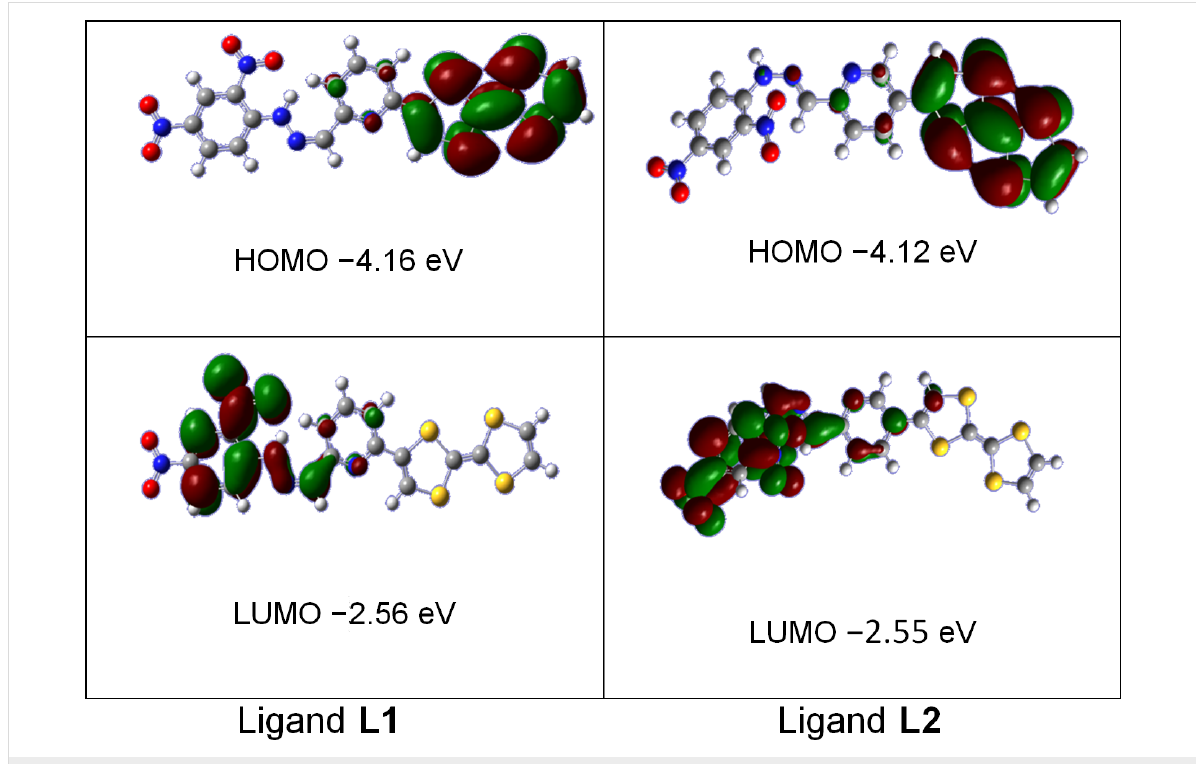
Figure 5: HOMO–LUMO Frontier orbitals representation for ligands L1 and L2 .